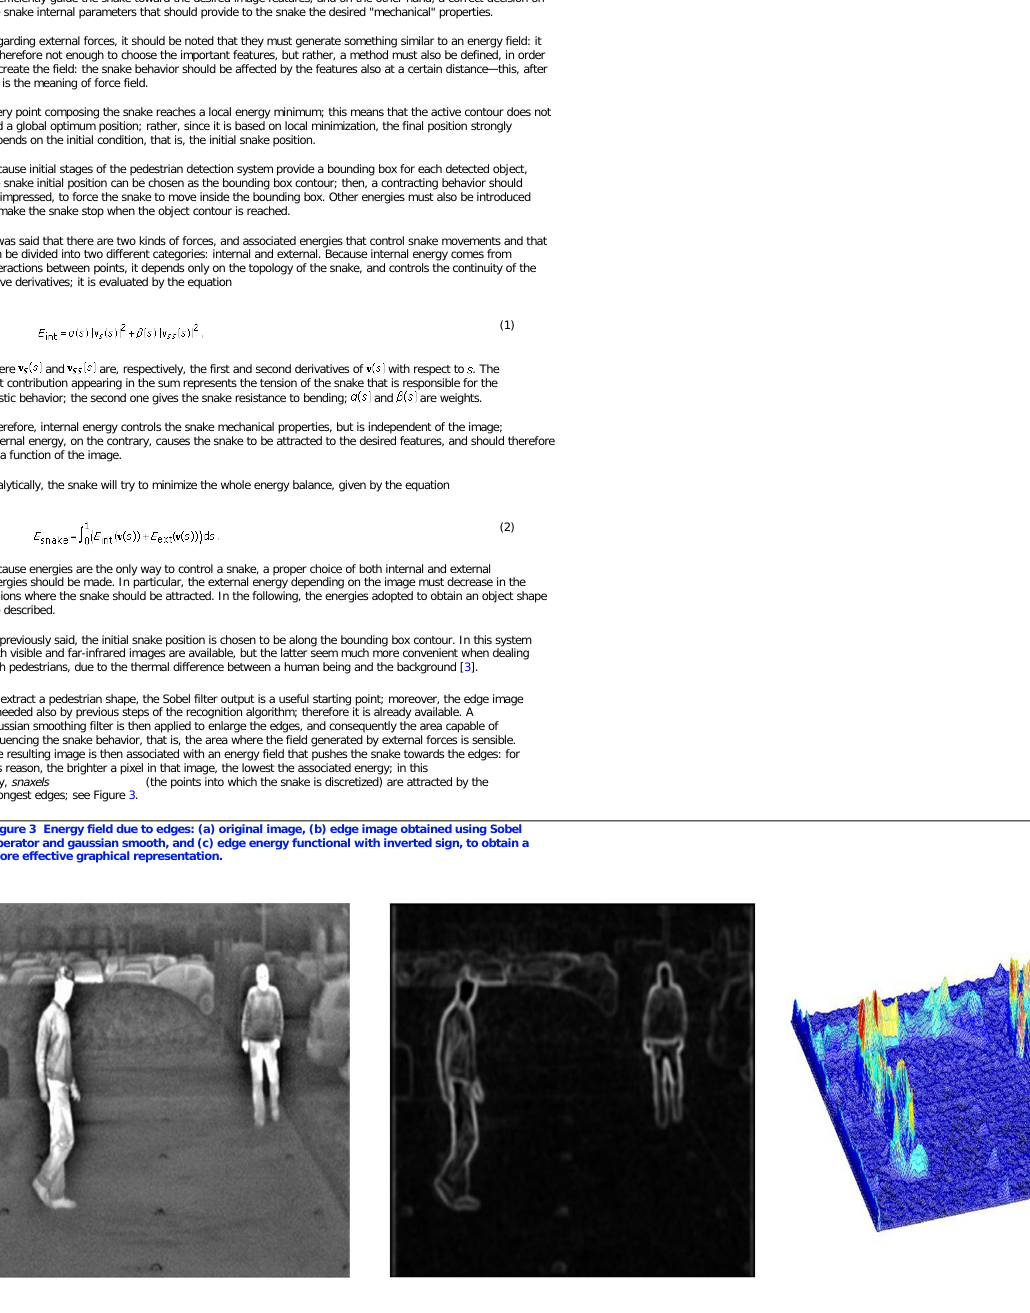
Bright regions of the original FIR image are also considered. In fact, smoothed edges do not accurately define the object contour (mainly because they are smoothed): snake contraction has to be arrested by bright regions in the FIR image that can belong to a portion of a human body (see Figure 4). This method lets the